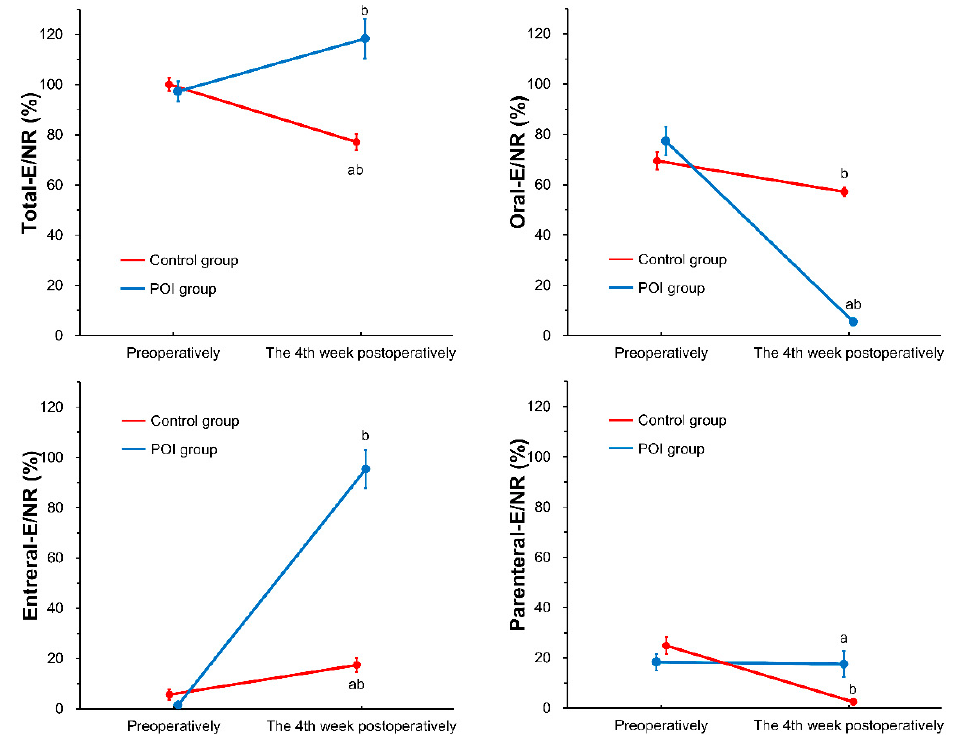
Figure 2. Changes of energy intake for each administration route in hospital. Differences between two study groups and two study time points were analyzed using split-plot analysis of variance and Bonferroni adjustment for multiple comparisons. Data are shown as mean ± standard error. a, p < 0.05 (vs. control); b, p < 0.05 (vs. preoperatively); POI group, poor oral intake group